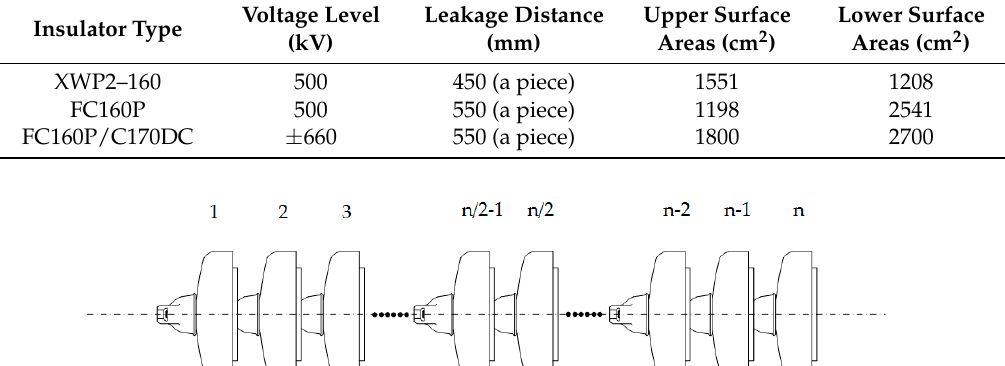
Table 1. The parameters of the suspension insulators.